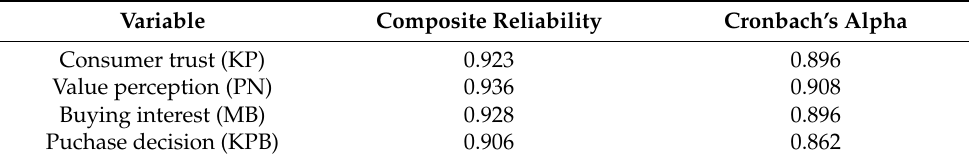
Table 2. Reliability Test.